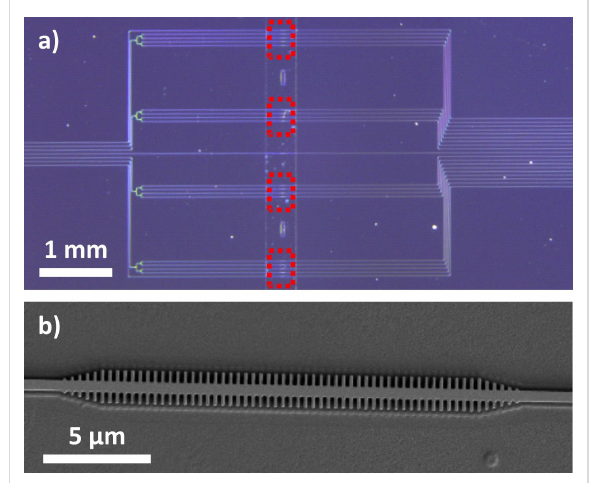
Figure 1: (a) Optical microscopy image of the fabricated photonic chip. Each of the PBG sensors groups are marked with a red dotted square. (b) Scanning electron microscopy image of one of the PBG sensing structures within the